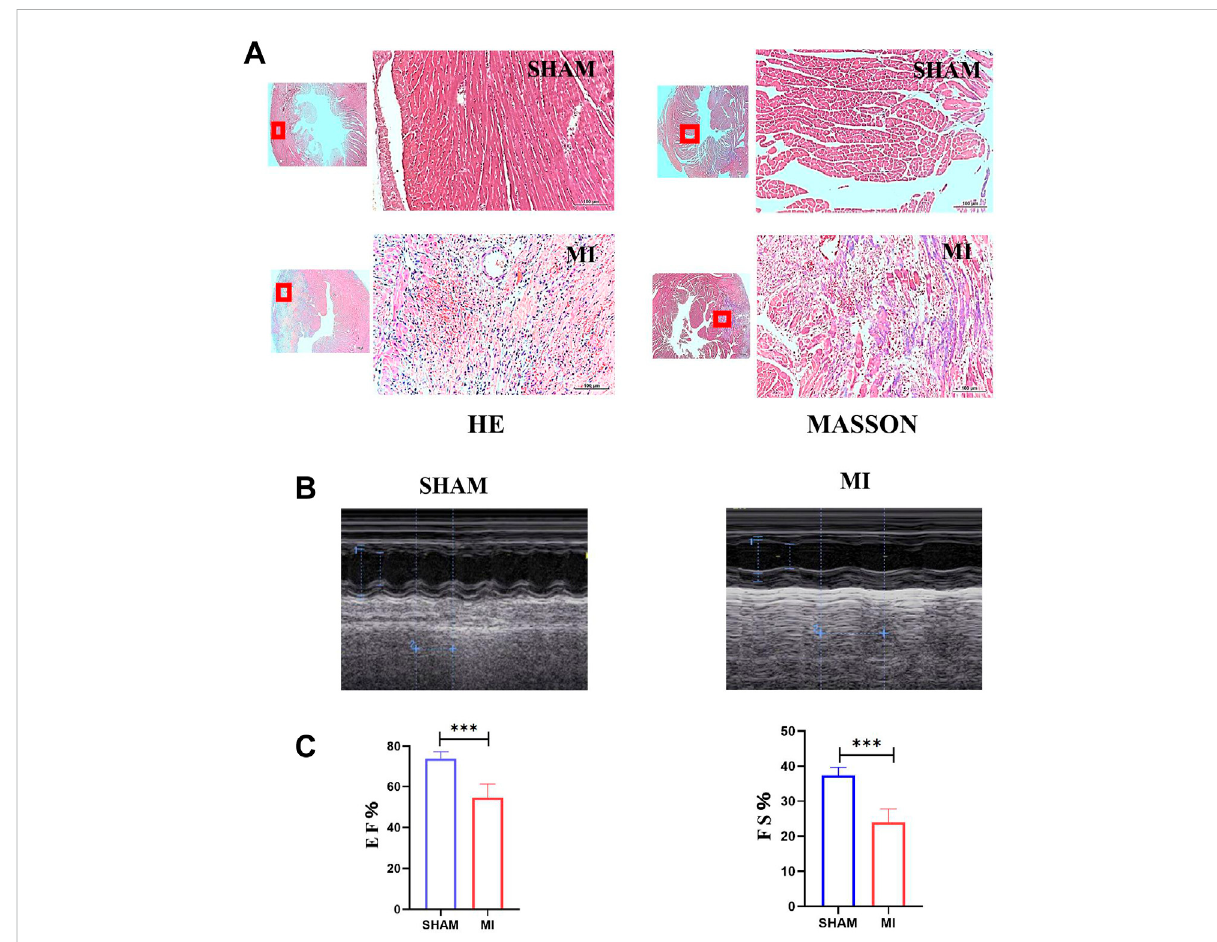
FIGURE 3 Establishment of theMI model of mice. (A) H&E and Masson staining of hearts of mice in SHAM and MI groups. (B) Ultrasonic detection of heart function in mice in the SHAM and MI groups. (C) FS and EF of mice in SHAM and MI groups (mean ± SD, n = 5). ***, p < 0.001; Scale bars: 100 μ